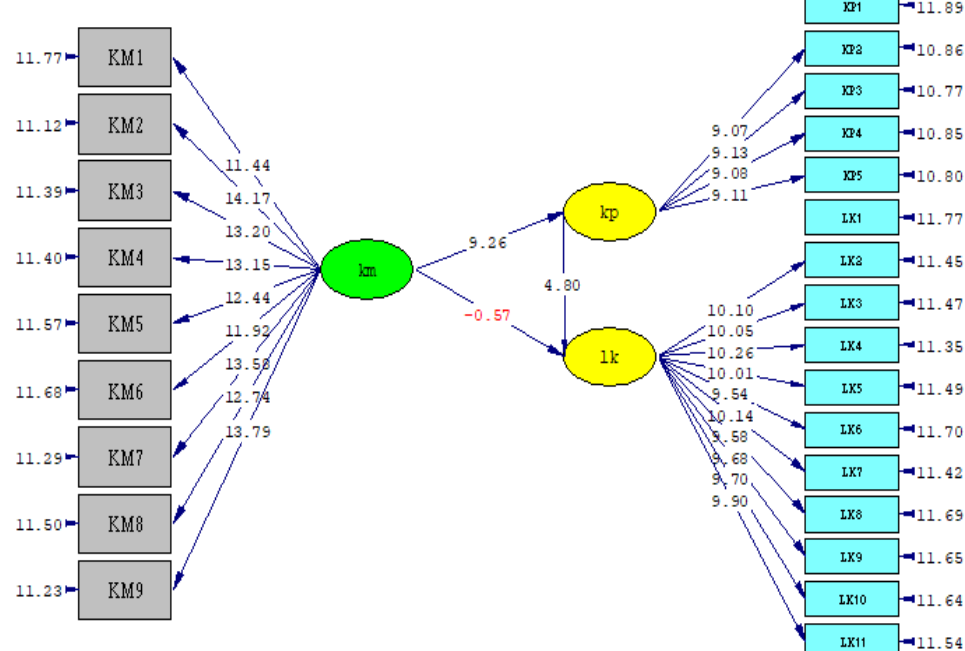
Figure 3. Structural model fit test results